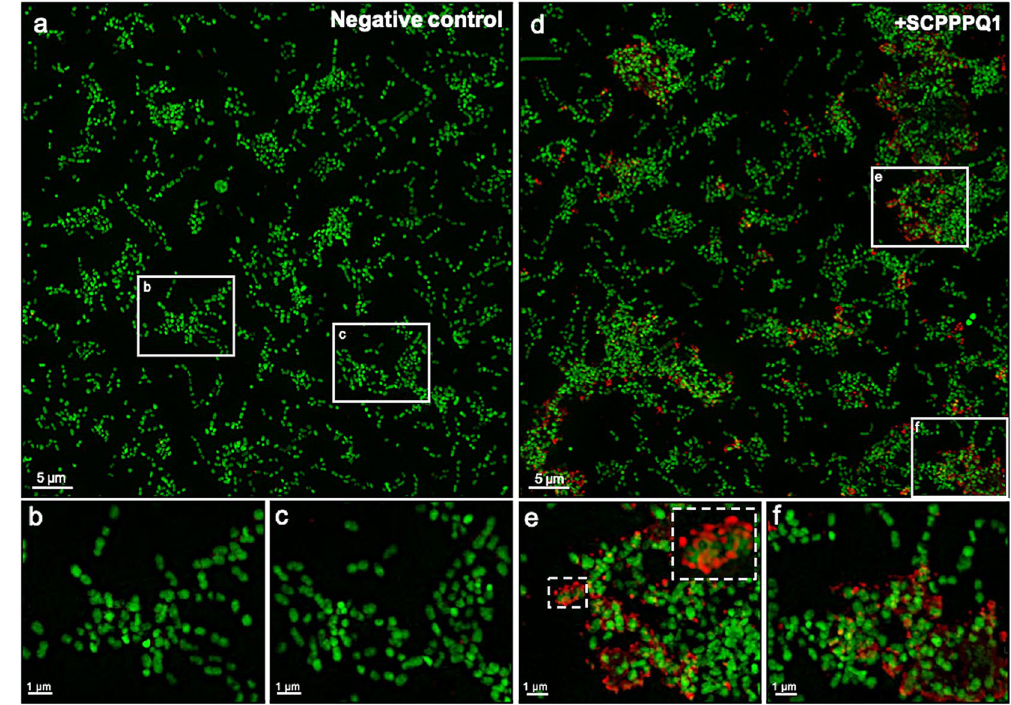
Figure 5. Localisation of SCPPPQ1 on P. gingivalis using super-resolution fluorescence imaging. ( a – c ) Images of bacteria incubated with the buffer only (negative control) at 20 min. ( b , c ) Enlargements of corresponding boxed areas in ( a ). ( d – f ) Images of bacteria incubated with + SCPPPQ1 at 20 min. ( e , f ) Enlargements of corresponding boxed areas in ( d ). ( e ) Upper dashed box is a magnification of the lower one. Bacterial nucleic acids were labeled with SYTO 9 (green fluorescence) and SCPPPQ1 with Alexa Fluor-546 secondary antibody (red fluorescence). These images are representative from four different